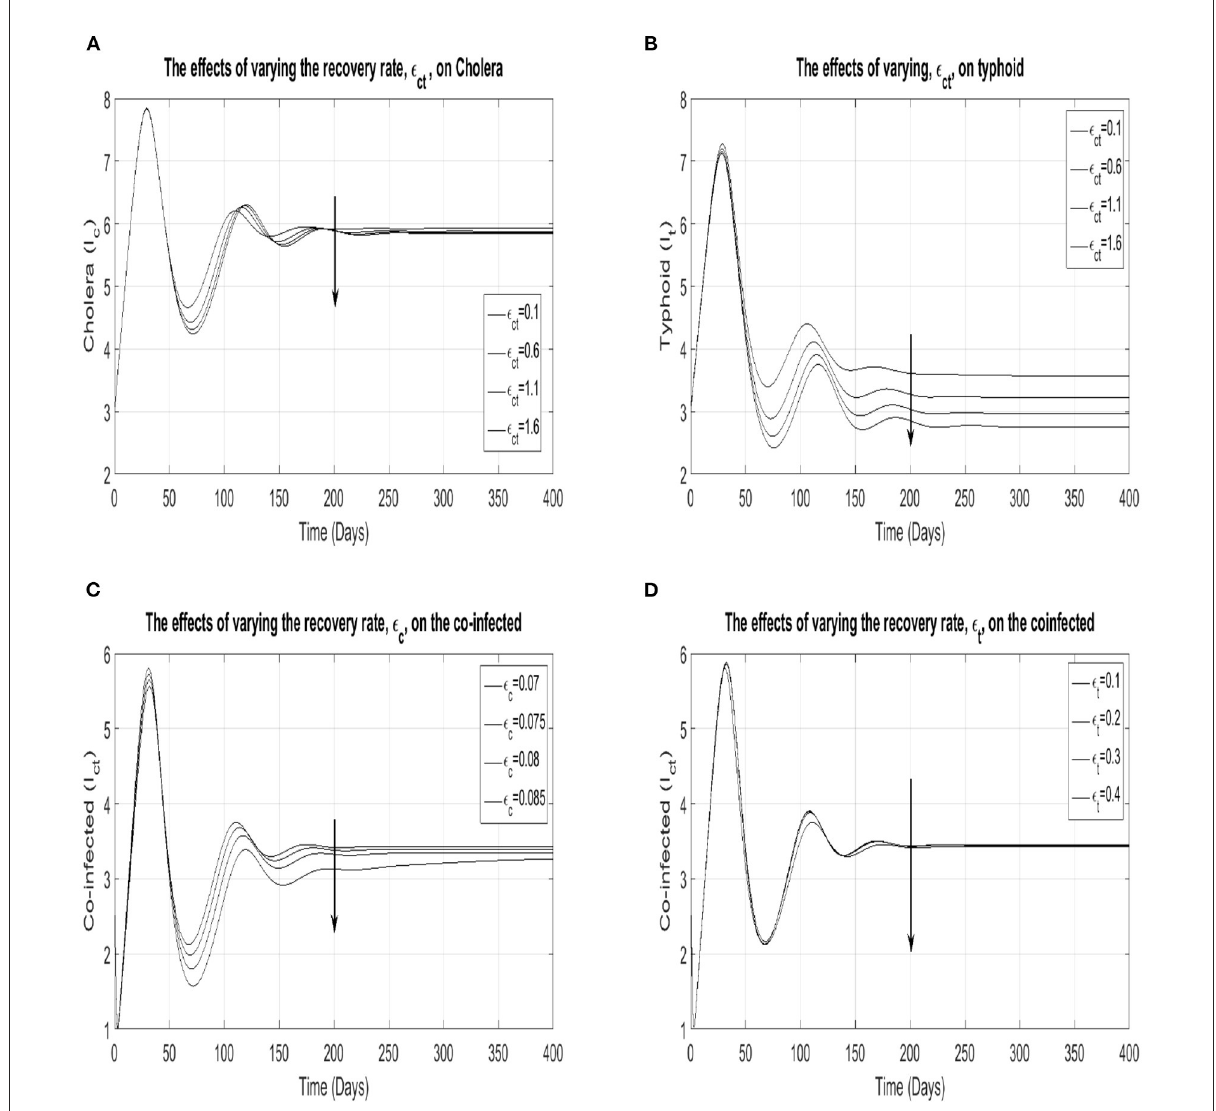
FIGURE5 Plots (A,B) show the cholera and typhoid prevalence, respectively, as the co-infection recovery rate, ǫ ct , runs through { 0.1,0.6,1.1,1.6 } . Plots (C,D) show the prevalence of the co-infected as the cholera and typhoid recovery rates are varied through the sets { 0.07,0.075,0.08,0.085 } and { 0.1,0.2,0.3,0.4 } ,